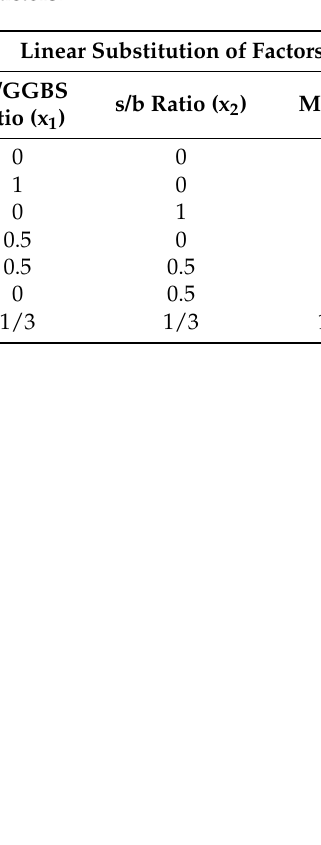
Table 5. The actual value and linear substitution of three factors.